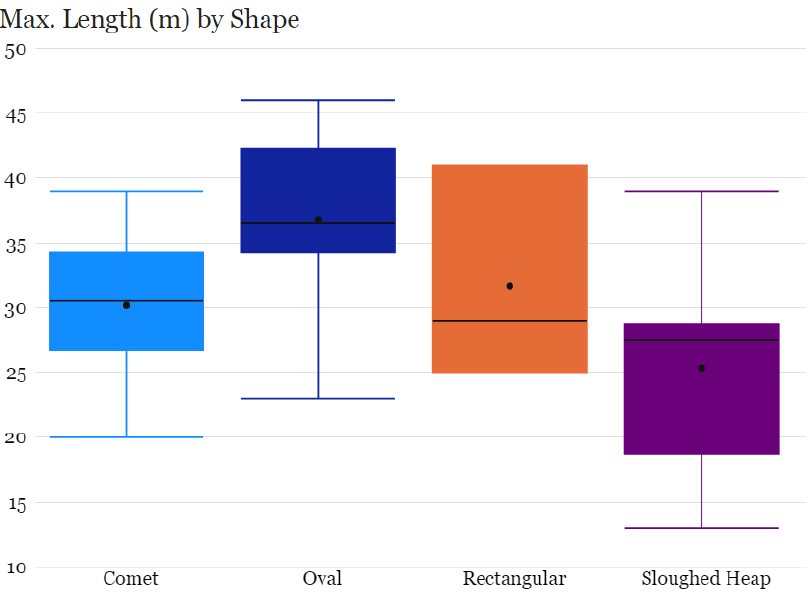
Figure 5. Box Charts of Max. Length (m) by Dump Profile Shape.